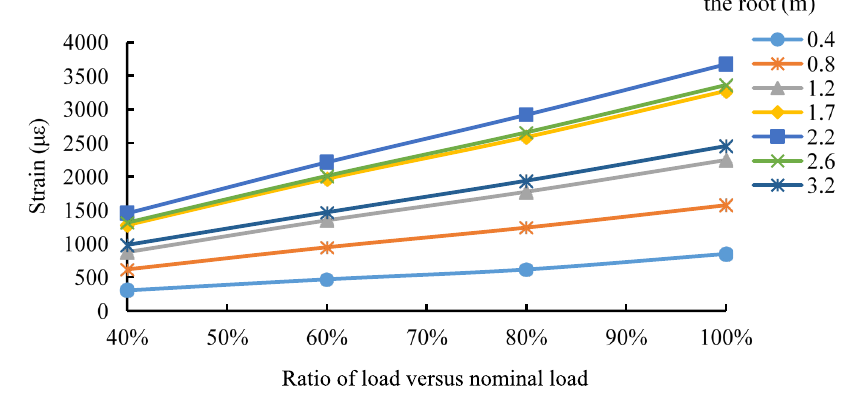
Figure 3. Strain versus load at the measurement points.